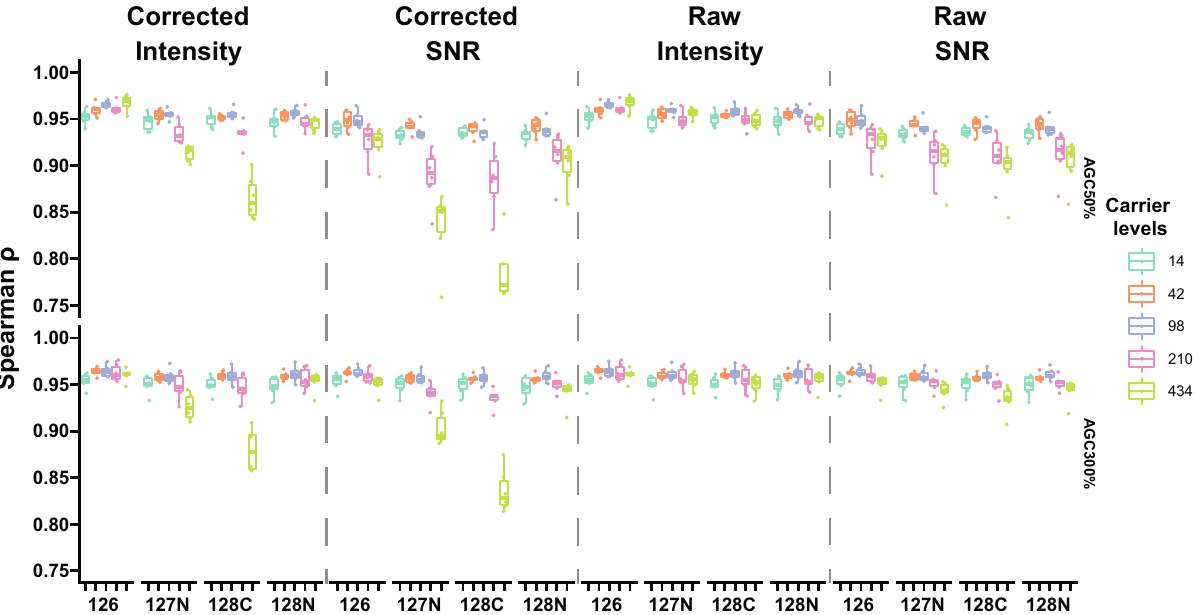
Fig. 4 Correlation between MS1 abundances and abundances from selected reporter ion channels. MS1 abundances were calculated from Minora node in Proteome Discoverer. Four different kinds of reporter ion abundances were calculated including raw and impurity-corrected intensities, raw, and impurity-corrected SNR. The Spearman ’ s rank correlation coef fi cient was used as a measure of rank correlation. Table 1 Recommended settings in Orbitrap instruments for isobaric labeling-based single-cell proteomics. Parameter